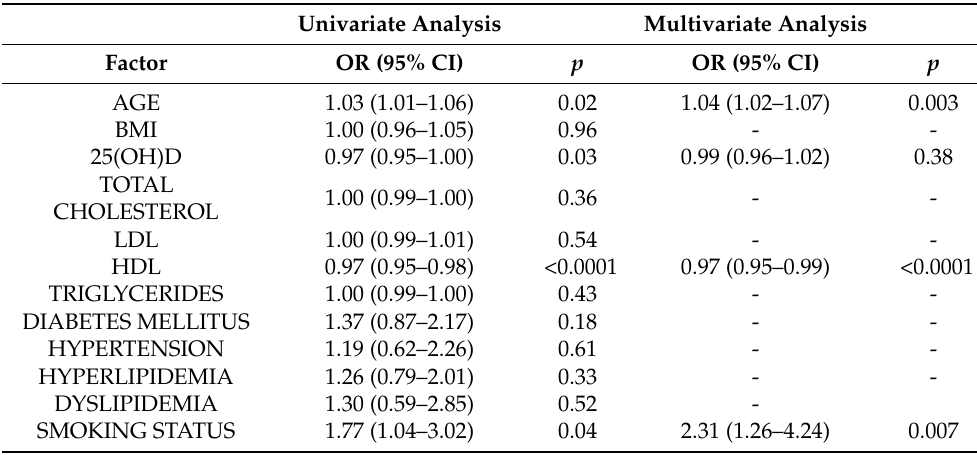
Table 4. Risk and protective factors for